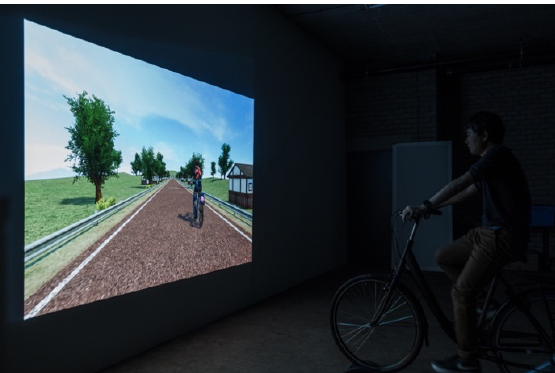
Figure. 9. The experiment setup of